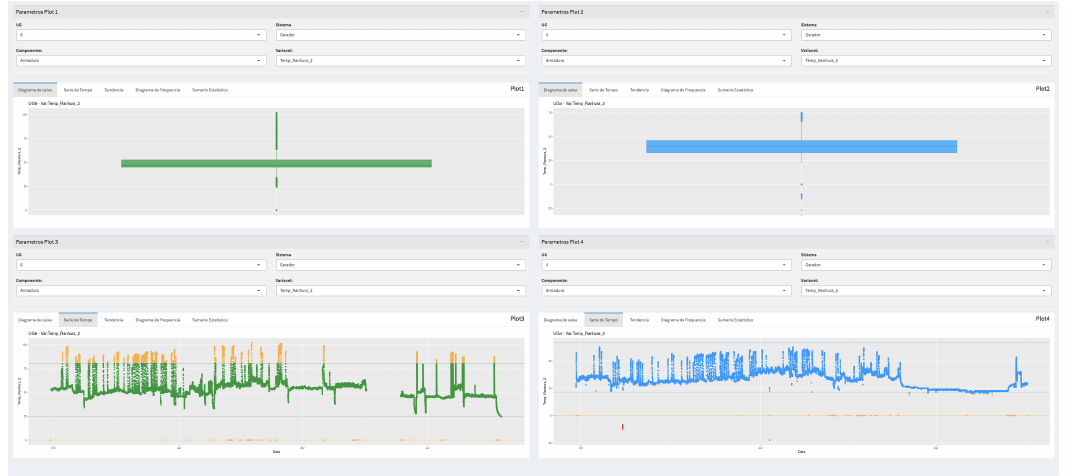
Figure 6. Rotor Groove—Comparison GU4 vs. GU6—Boxplot and Time Series.